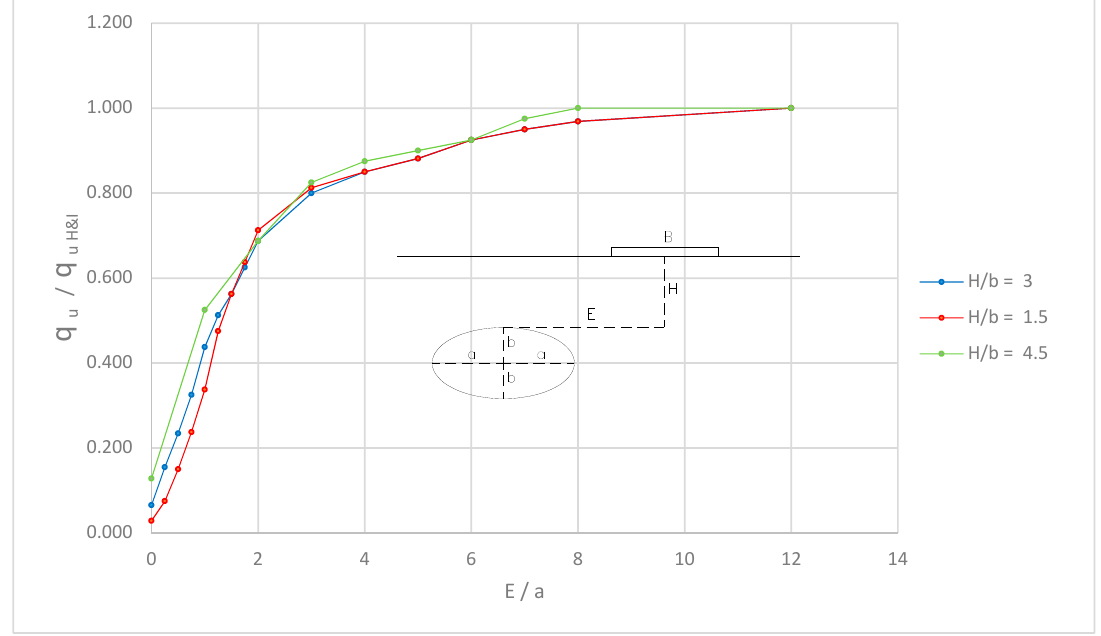
Figure 7. The load eccentricity on the ultimate bearing capacity for values between E / a = 0 and E / a = 12.